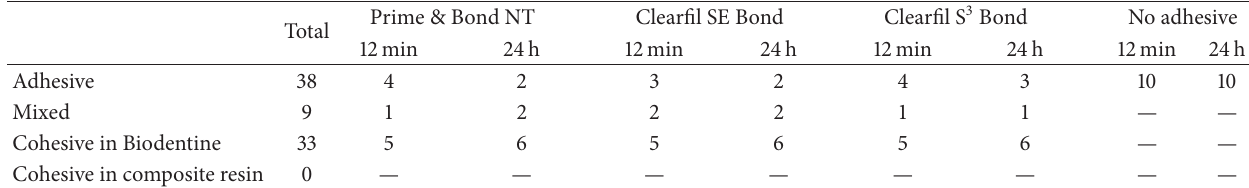
Table 3: Fracture modes of thespecimens after shear bond test